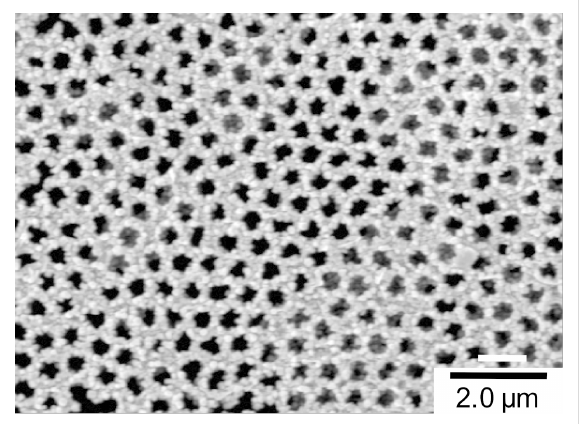
Figure 4: SEM image of ZnO nanocrystal clusters nucleated on a honeycomb pattern with the spatial pitch of 500 nm.